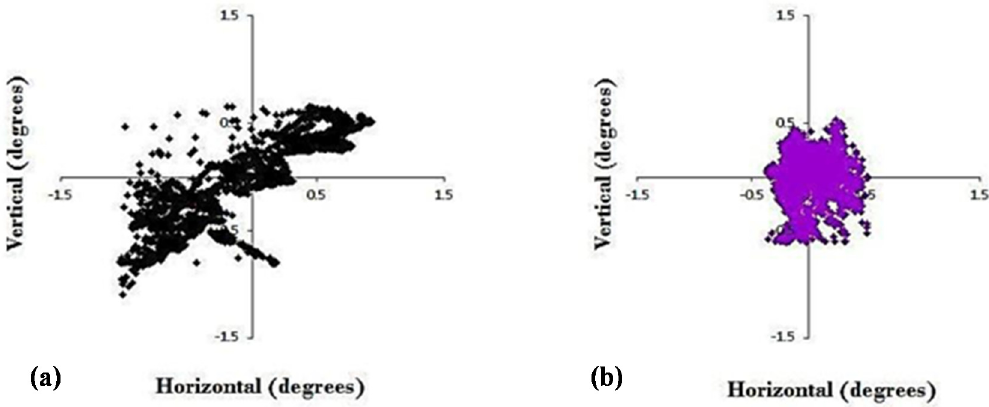
Figure 2. Two-dimensional plot of binocular central fixation before ( a ) and after ( b ) oculomotor training in a typical mTBI subject. Data presented from the right eye [17].